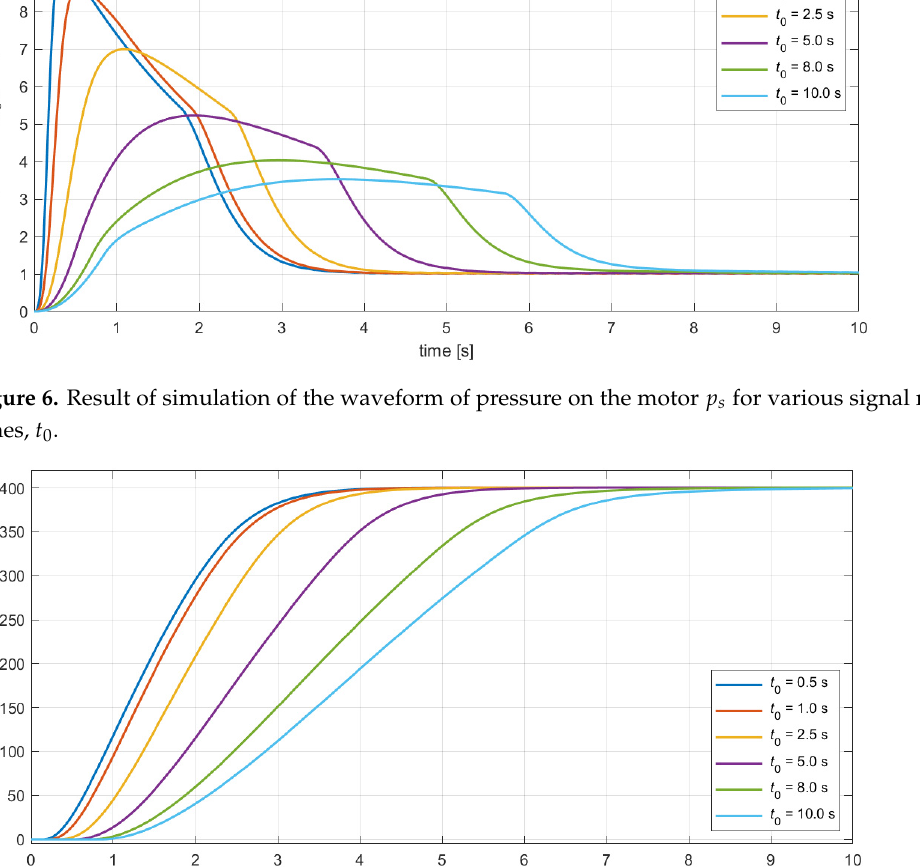
Figure 7. Result of simulation of the waveform of rotational speed n s for various signal rise times, t 0 .